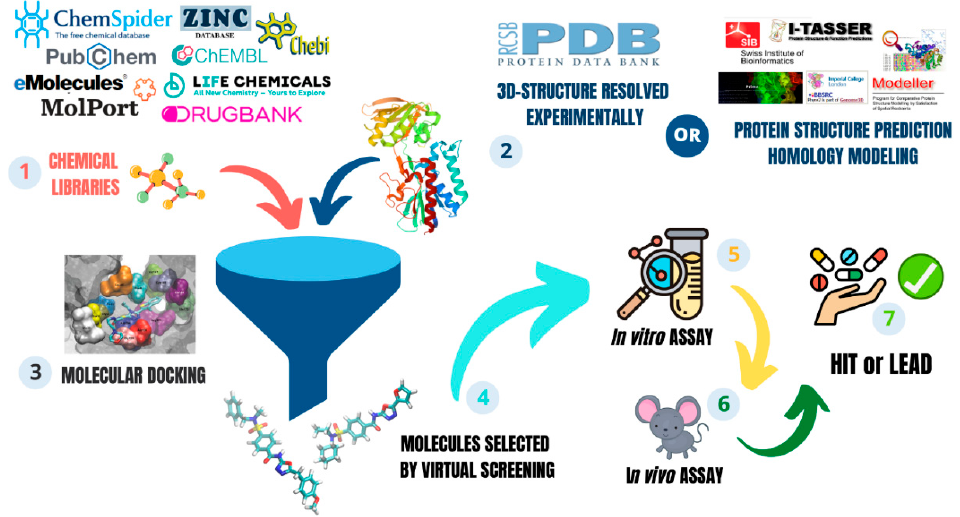
Figure 3. Drug design by in silico approaches. This process can be divided into at least seven steps. (1) Prepare the molecules libraries with filters such as Lipinski’s rule. Currently different databases are commercially available: https://www.molport. com/shop/index; http://www.chemspider.com/; https://zinc.docking.org/; https://www.ebi.ac.uk/chebi/; https://reaxys. emolecules.com/index.php; https://go.drugbank.com/; https://www.ebi.ac.uk/chembl/; https://pubchem.ncbi.nlm.nih. gov/; https://lifechemicals.com; (2) Prepare the target protein, either from the experimentally solved protein database (https://www.rcsb.org/) or by homology modeling (https://salilab.org/modeller/; https://zhanglab.ccmb.med.umich.edu/I- TASSER/; http://www.expasy.org/resources/swiss-model; https://robetta.bakerlab.org/; https://www.schrodinger.com/ prime; (3) Analyze the in silico data in search of new molecules (4) Perform the experiments in vitro; (5) Analyze the results in vitro to start point (6) in vivo experiments; (7) Compounds that meet all the requirements can sequence with the hit-to- lead